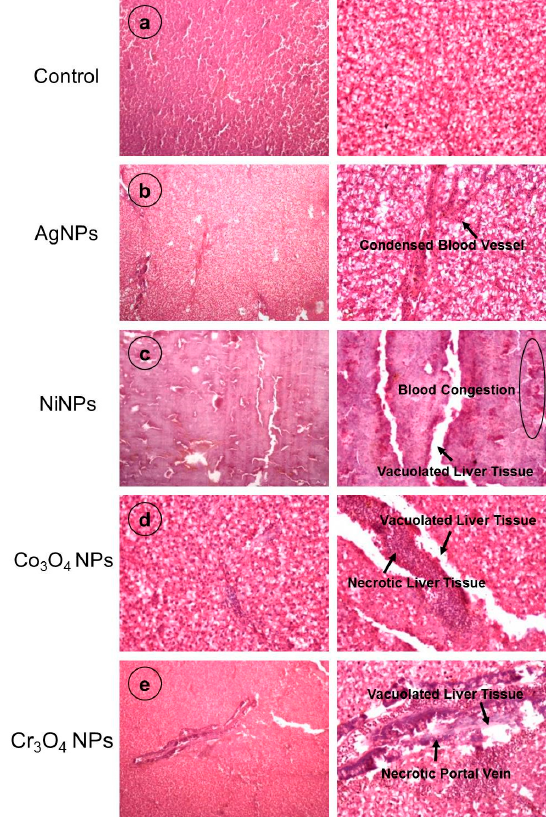
Figure 11. Histological examination of liver of fish exposed to NPs in comparison with control fish showing different types of damage caused by NPs treatment. Magnifications: 10× (left side), 40× (right side).